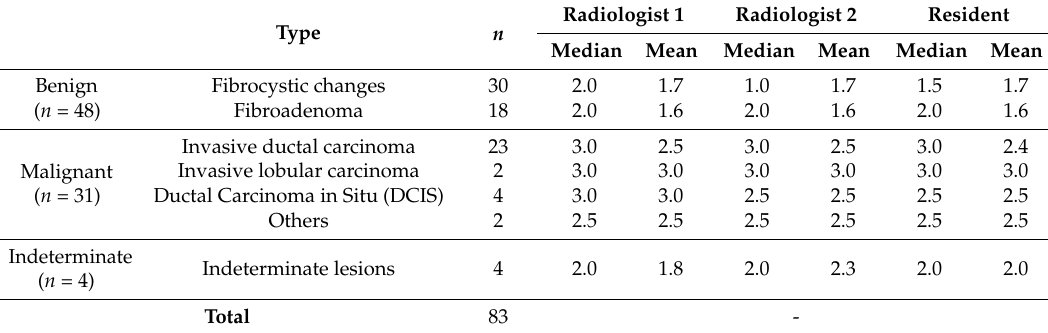
Table 4. Distribution of the final classification according to the score adopted, where score 1 represents soft lesions; score 2 represents intermediate; and score 3 is associated with hard lesions.